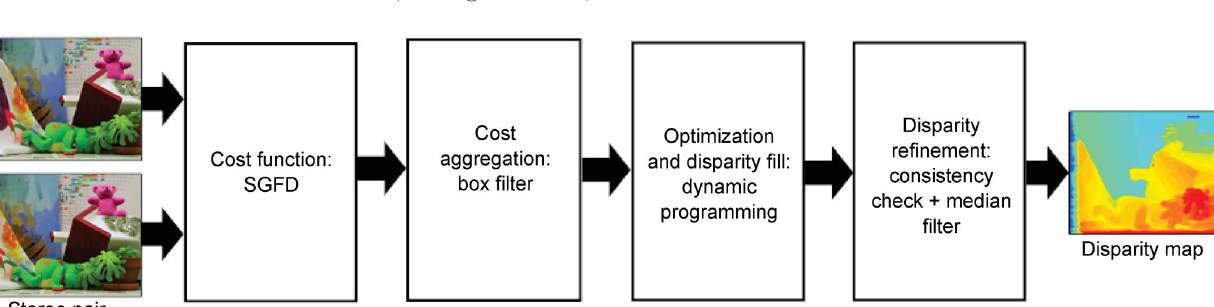
Fig. 1 Block diagram of our